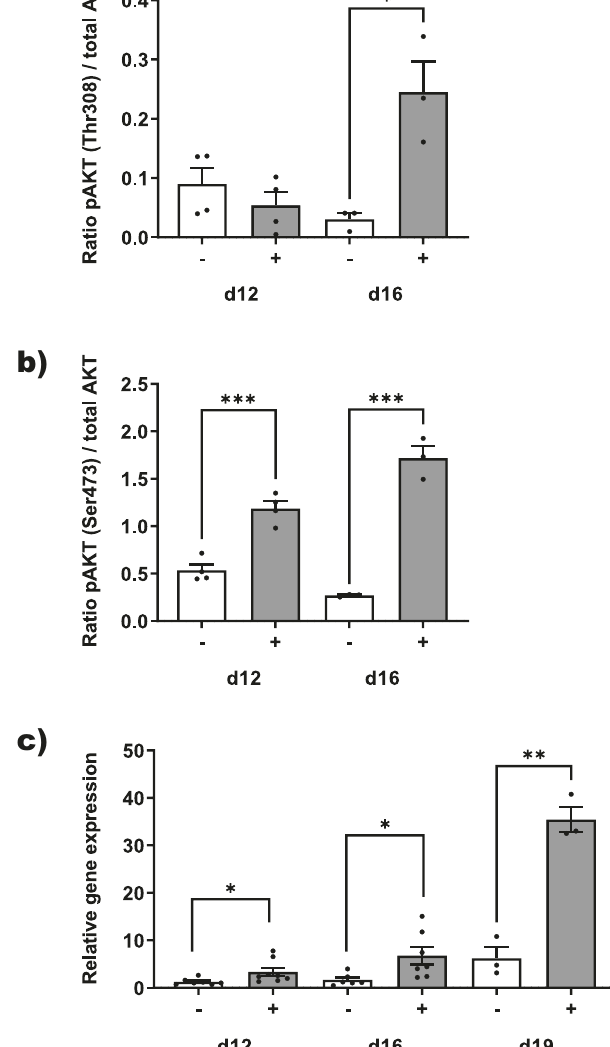
Fig. 4 EPS-induced repetitive model contractions activate Akt hypertrophy pathway and induce IL-6 myokine expression. 3D models ( n ≥ 3) from a 19-year-old donor, differentiated for 12 (d12), 16 (d16) and 19 days (d19), were stimulated by high impact EPS ( + ) for 3 h or left untreated as controls ( − ). Induction of Akt phosphorylation as a ratio of total Akt was determined by Western Blotting. a Thr308 phosphorylation. b Ser473 phosphorylation. c Relative induction of IL-6 gene expression determined by qPCR and normalized by GAPDH expression. Shown are means ± sem. Statistics: Unpaired t -test, * p < 0.05, ** p < 0.01, *** p < 0.001.